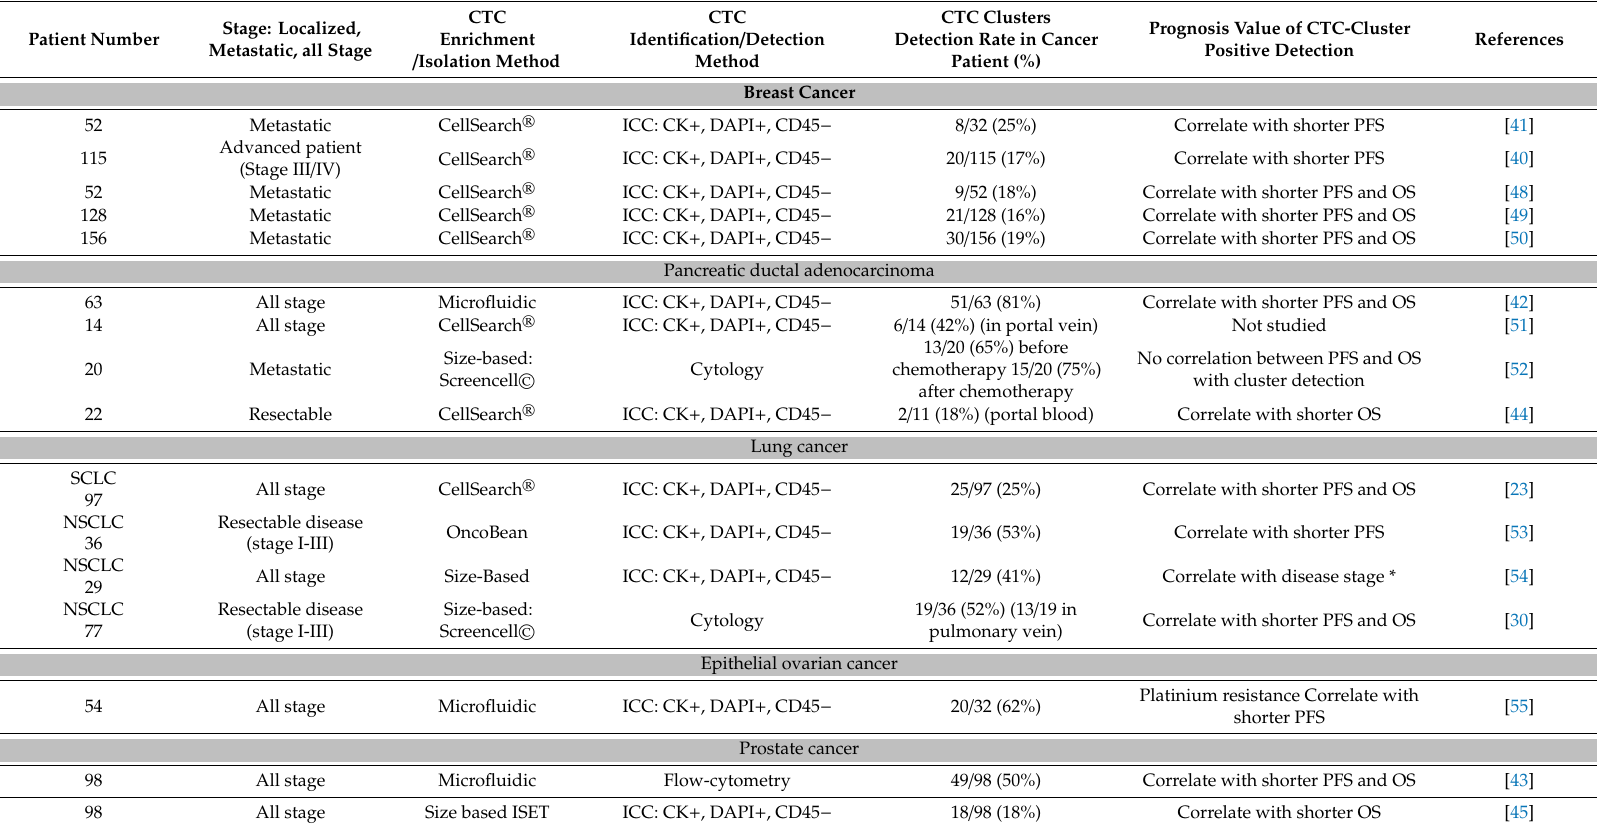
Table 1. Association of CTC clusters and clinical outcomes in cancer